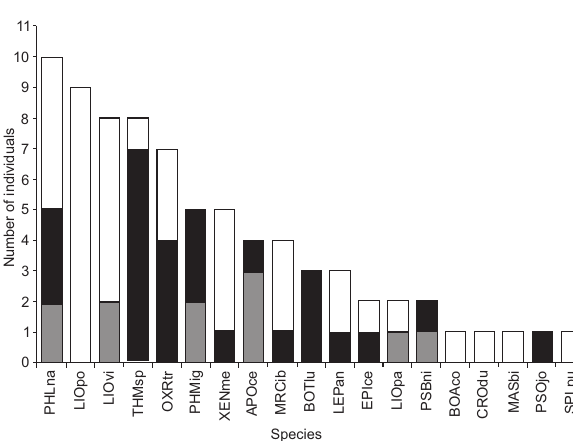
Figure 8. Relative abundance of snake species recorded at Castelo do Piauí (Piauí, Brazil) by using the methods of time constrained search (solid black), pitfall traps (gray), and incidental encounters (blank). (PHLna) Philodryas nattereri , (LIOpo) Liophis poecilogyrus , (LIOvi) Liophis viridis , (THMsp) Thamnodynastes sp., (OXRtr) Oxyrhopus trigeminus , (PHMig) Phimophis iglesiasi , (XENme) Xenodon merremii , (APOce) Apostolepis cearensis , (MCRib) Micru- rus ibiboboca , (BOTlu) Bothropoides lutzi , (LEPan) Leptodeira annulata , (EPIce) Epicrates assisi , (LIOpa) Liophis paucidens , (PSBni) Pseudoboa nigra , (BOAco) Boa constrictor , (CROdu) Crotalus durissus , (MASbi) Mastigodryas bifossatus , (PSOjo) Psomophis joberti , (SPLpu) Spilotes pullatus .